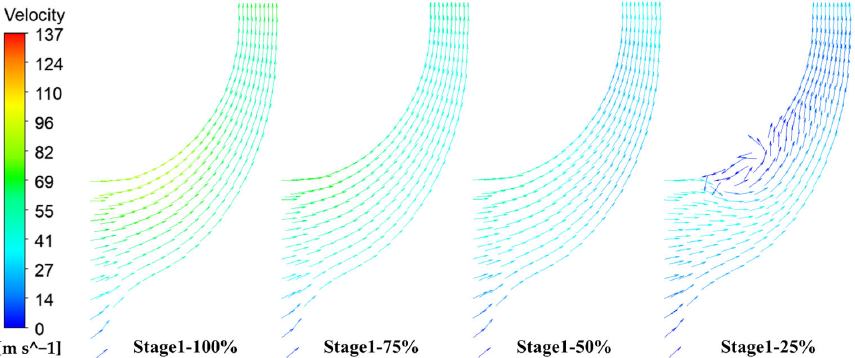
Figure 20. Impeller velocity vector diagram for the first stage compression with R-513A refrigerant under various loads.